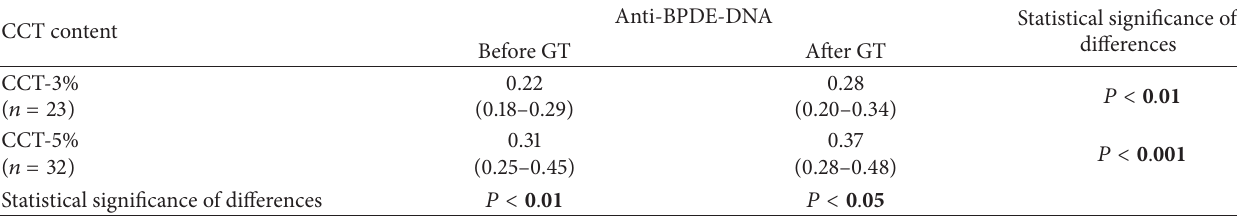
Table 1: The serum level of anti-BPDE-DNA before and after the therapy (all patients).